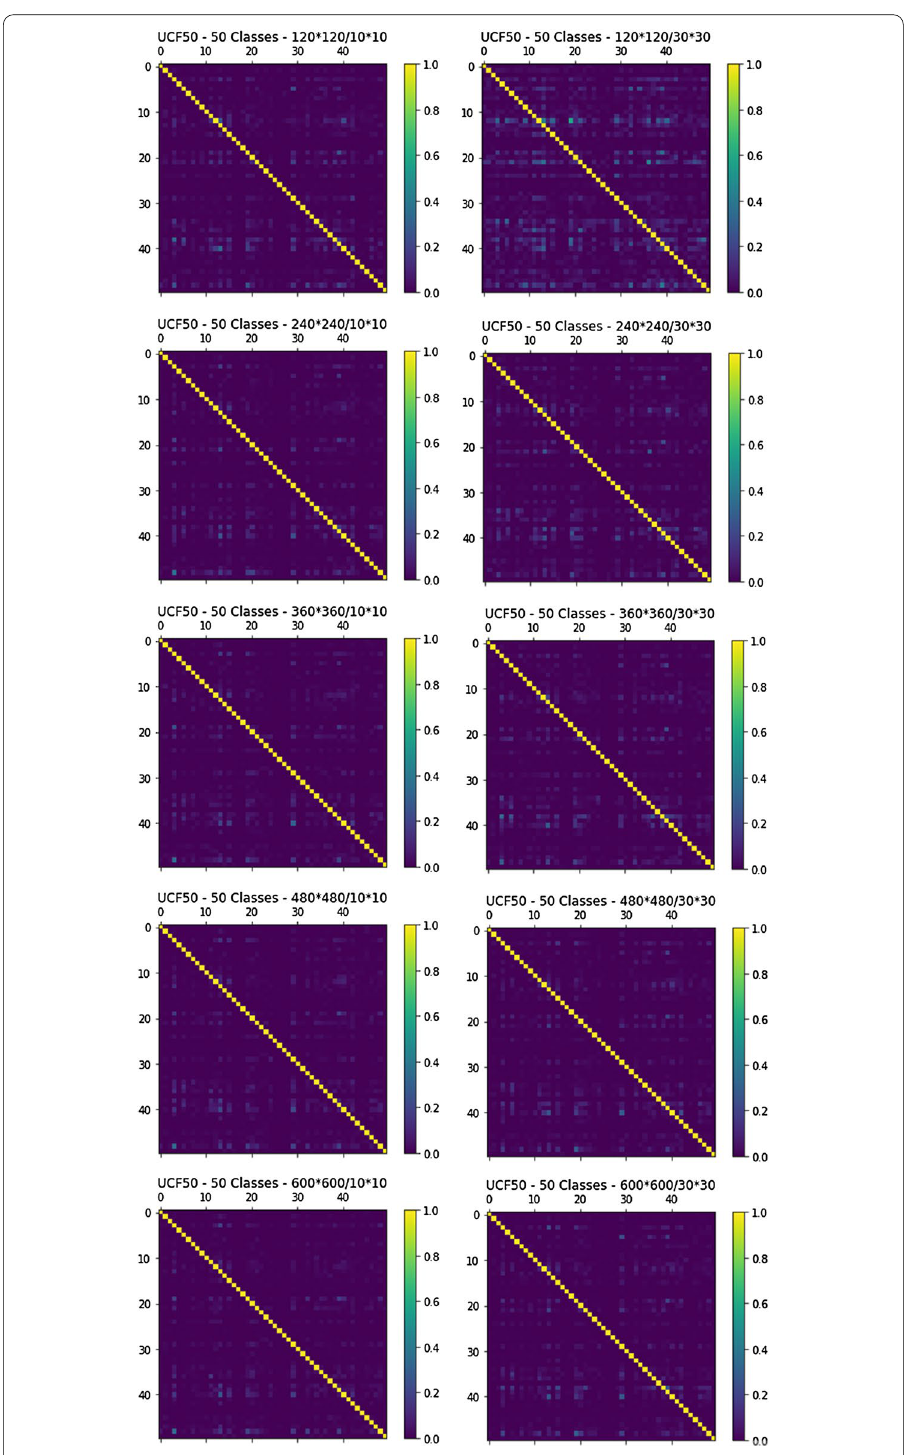
Fig. 12 Comparison of video classes’ accuracy—UCF50 (F‑size : 120*120 to 600*600, B‑size: 10 &